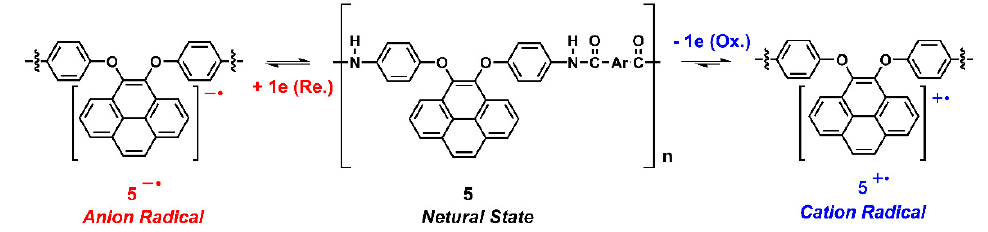
Scheme 4. Presumed redox chemistry of dietherpyrene-containing